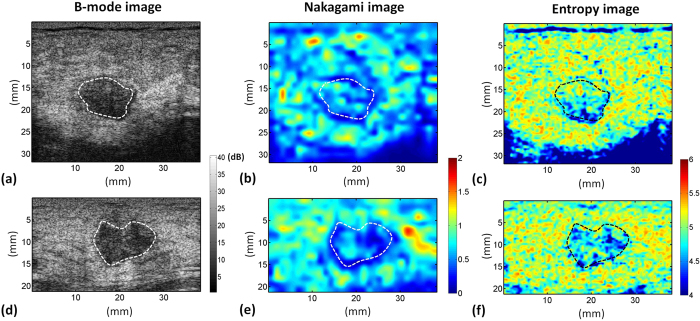
B-mode, Nakagami, and entropy (SL = 1) images of benign (a–c) and malignant (d–f) breast tumors. The shade of the Nakagami and entropy images of the malignant tumor was darker than that of the benign tumor.